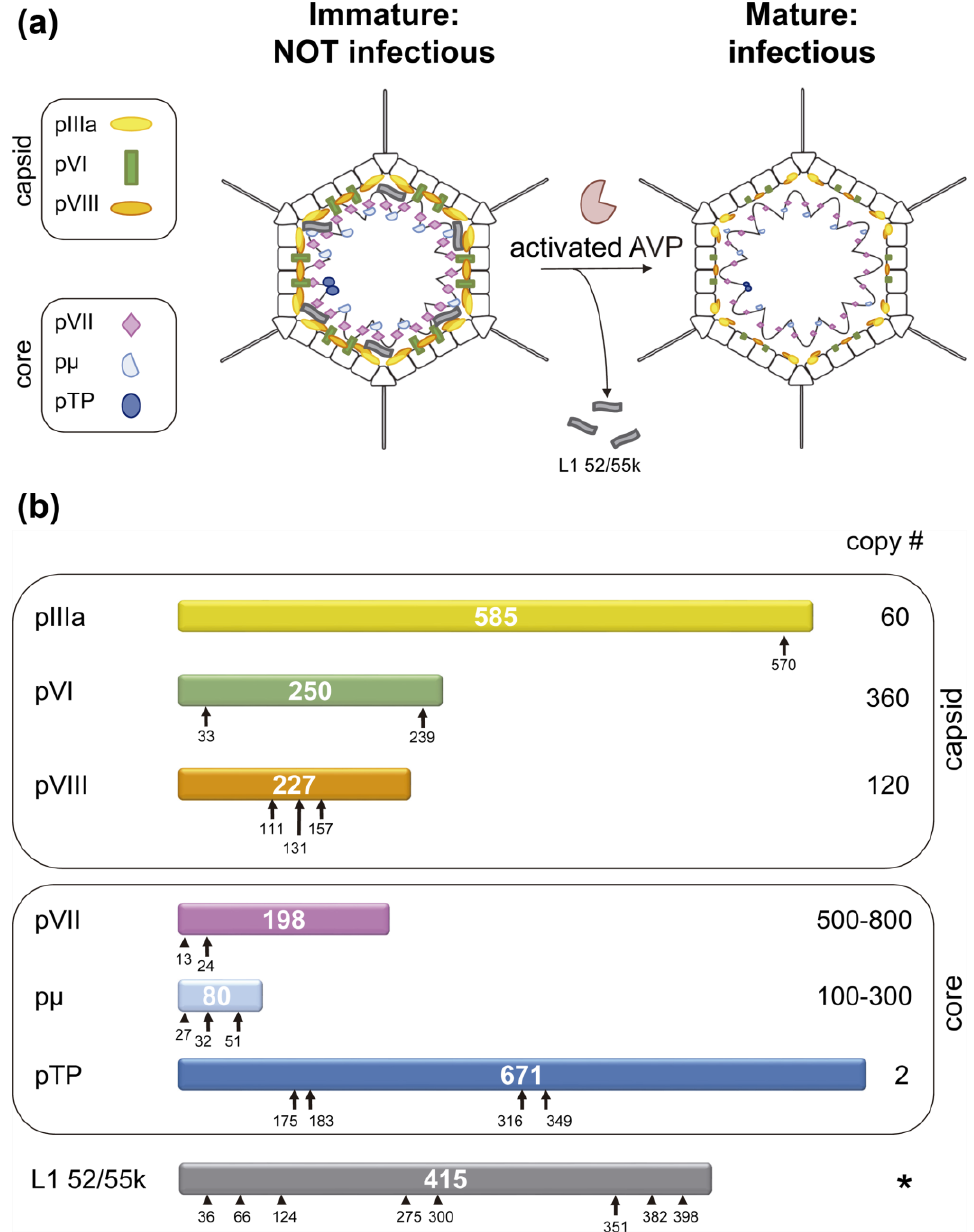
Figure 1. Substrates of the AdV maturation protease, AVP. ( a ) Schematics showing the location of substrates in the viral particle. The internal location of L1 52/55k is inferred from its interactions with core elements [59]; ( b ) Each HAdV-C2 precursor protein is represented as a bar with the polypeptide length in amino acids indicated in the center. Consensus cleavage sites are denoted by arrows, reported non-consensus sites by arrowheads [53,60]. The prefix “p” denotes the unprocessed precursors. Copy numbers are derived from stoichiometric analyses [18,19]. A star ( * ) in place of the copy number for L1 52/55k indicates that its copy number varies depending on the assembly stage: 100 copies in empty particles, 50 in fully packaged, immature ts1 particles, and 0 in mature virions [46,60]. Panel ( b ) modified from